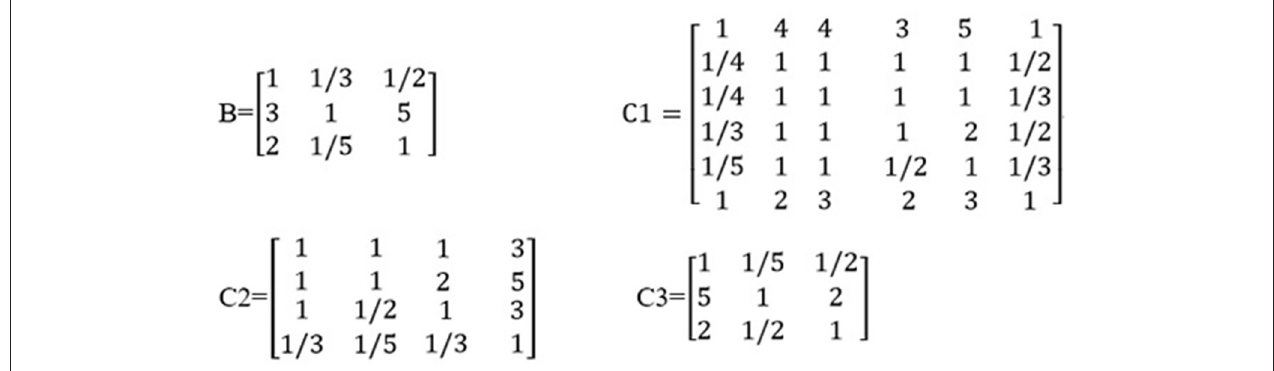
FIGURE 2 | The distribution of the importance degree matrix.